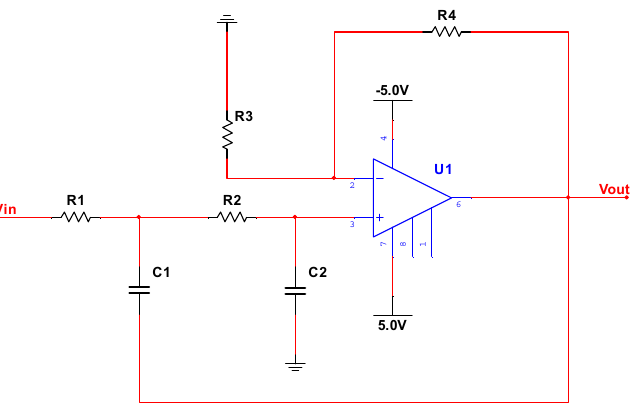
Figure 8. T wo-order low-pass filter circuit. Figure 8. Two-order low-pass filter circuit.